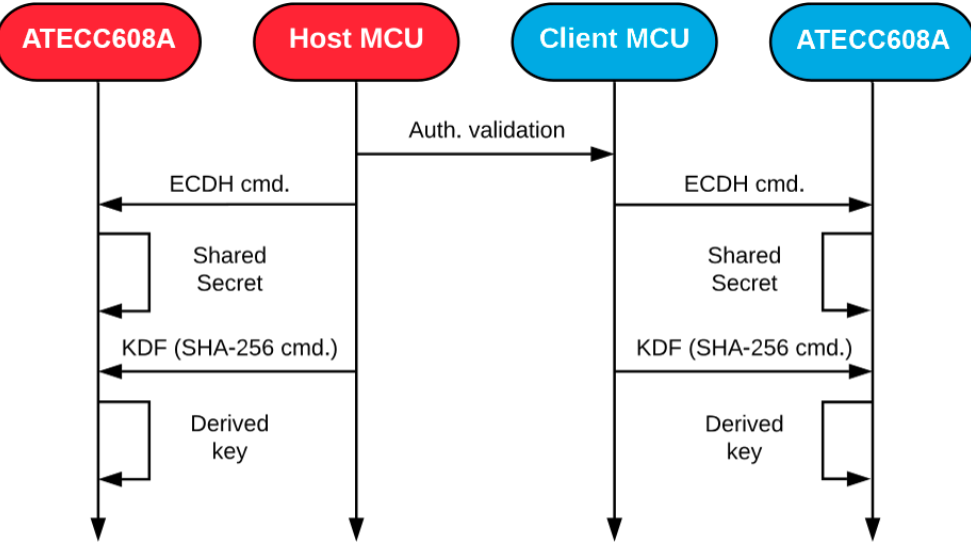
Figure 5. Time diagram of the steps followed to change from asymmetric cryptography to symmetric cryptography.